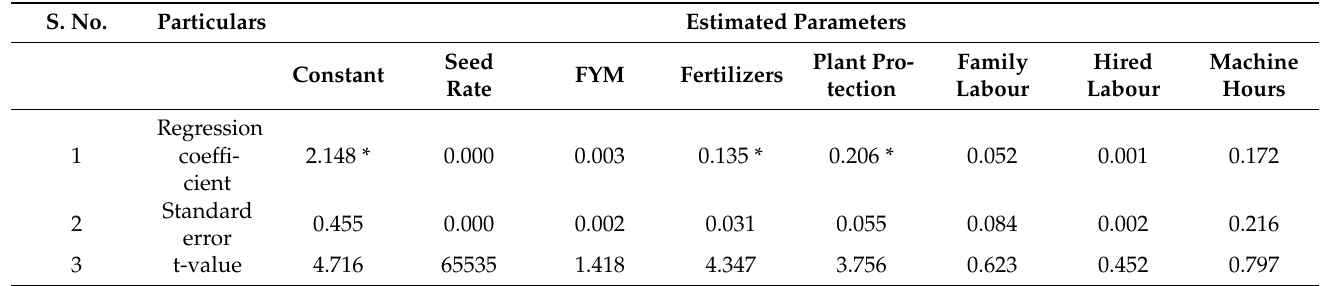
Table 8. Production function estimates of marigold cultivation in Jammu district.